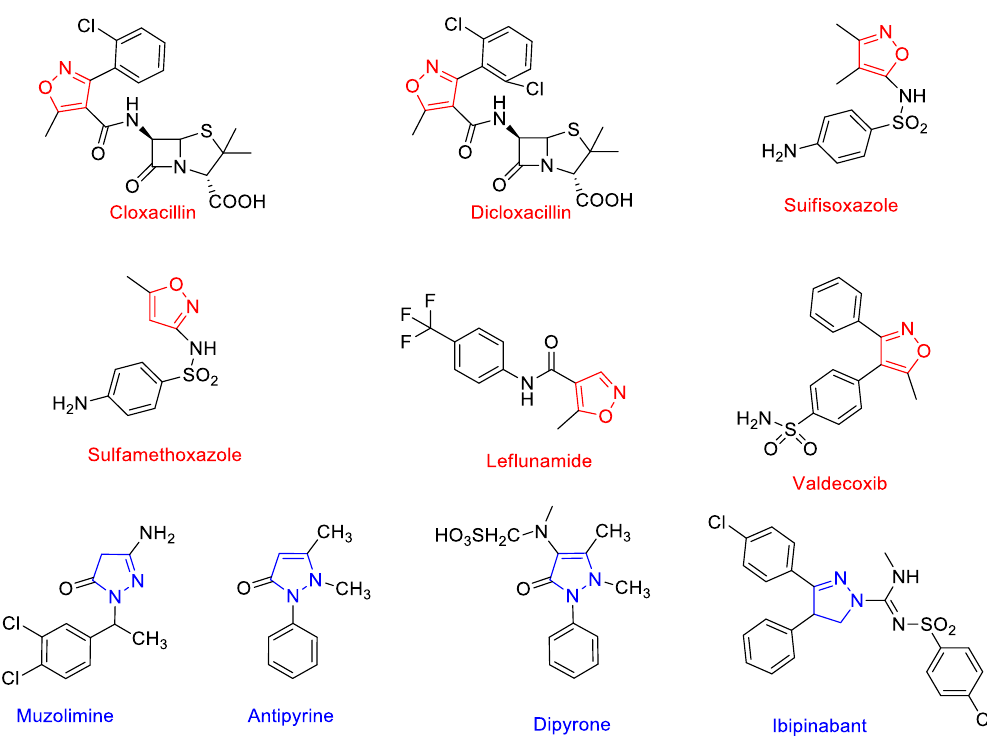
Figure 1. Structures of some clinically useful drugs containing isoxazole and dihydropyrazole